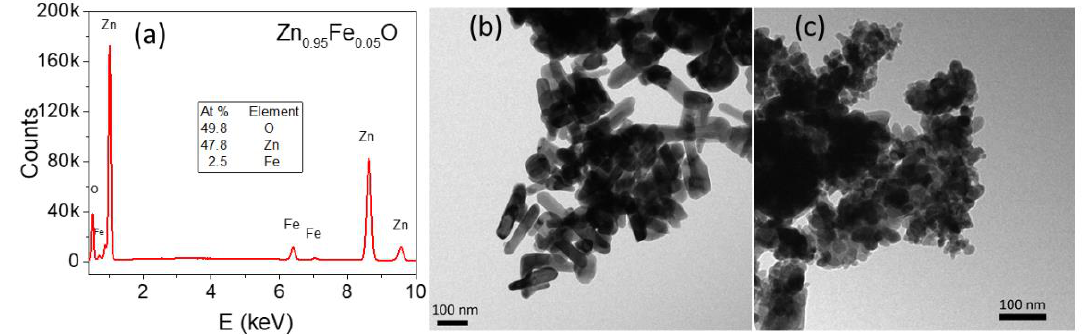
Figure 2. EDX spectrum of the Zn 0.95 Fe 0.05 O sample ( a ); TEM images for the ZnO ( b ) and Zn 0.95 Fe 0.05 O ( c ) samples.